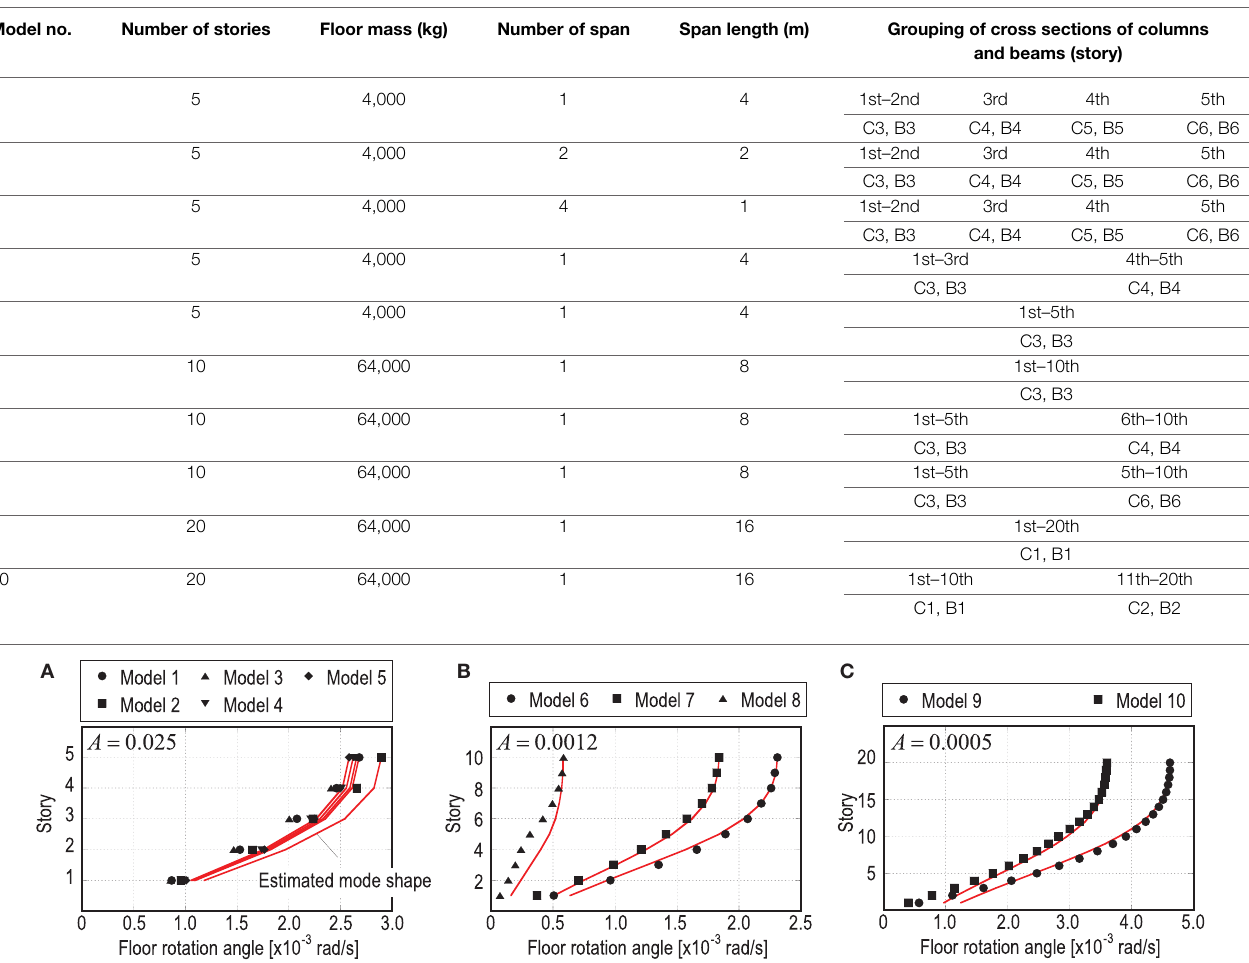
TABLE 2 | Properties of building model. Model no.